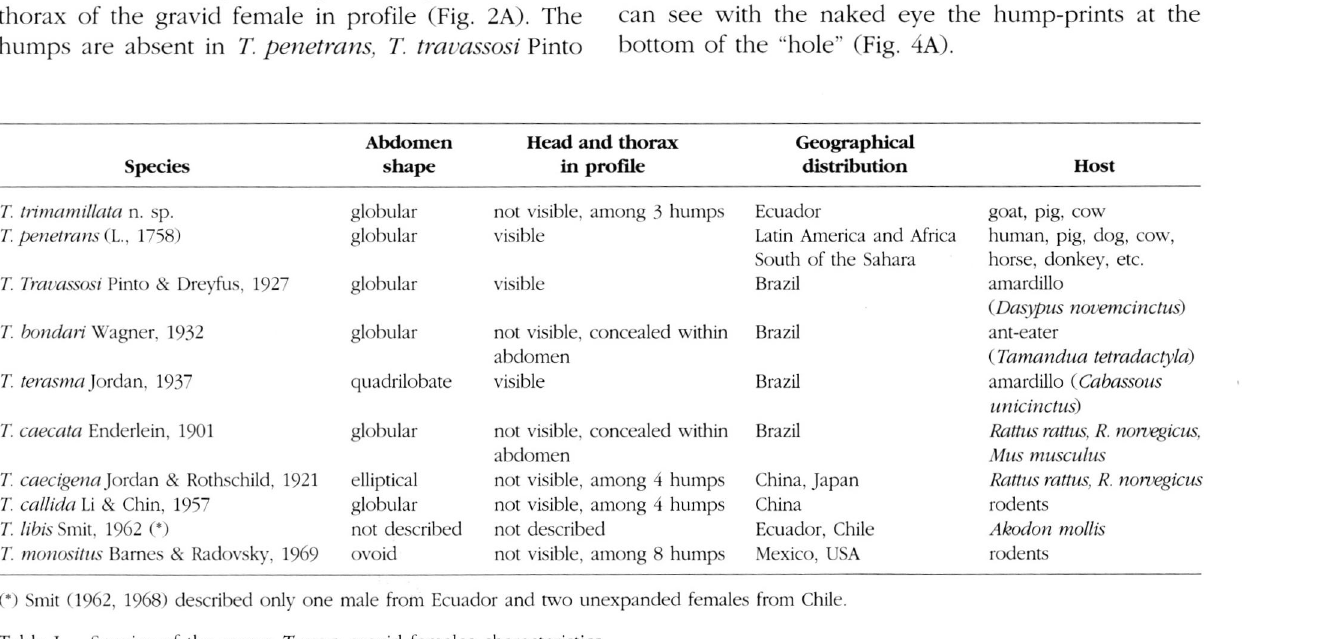
Table I. - Species of the genus Tunga : gravid females characteristics. Parasite, 2003, 10,